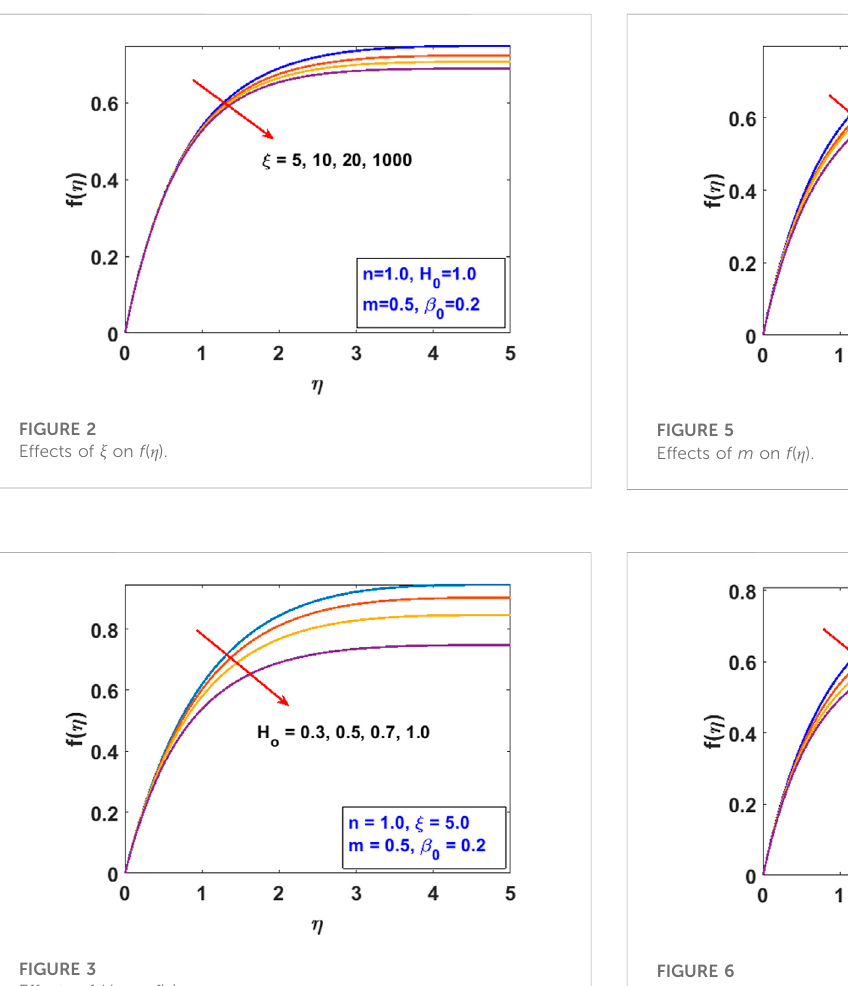
FIGURE 6 Effects of n on f ( η ).